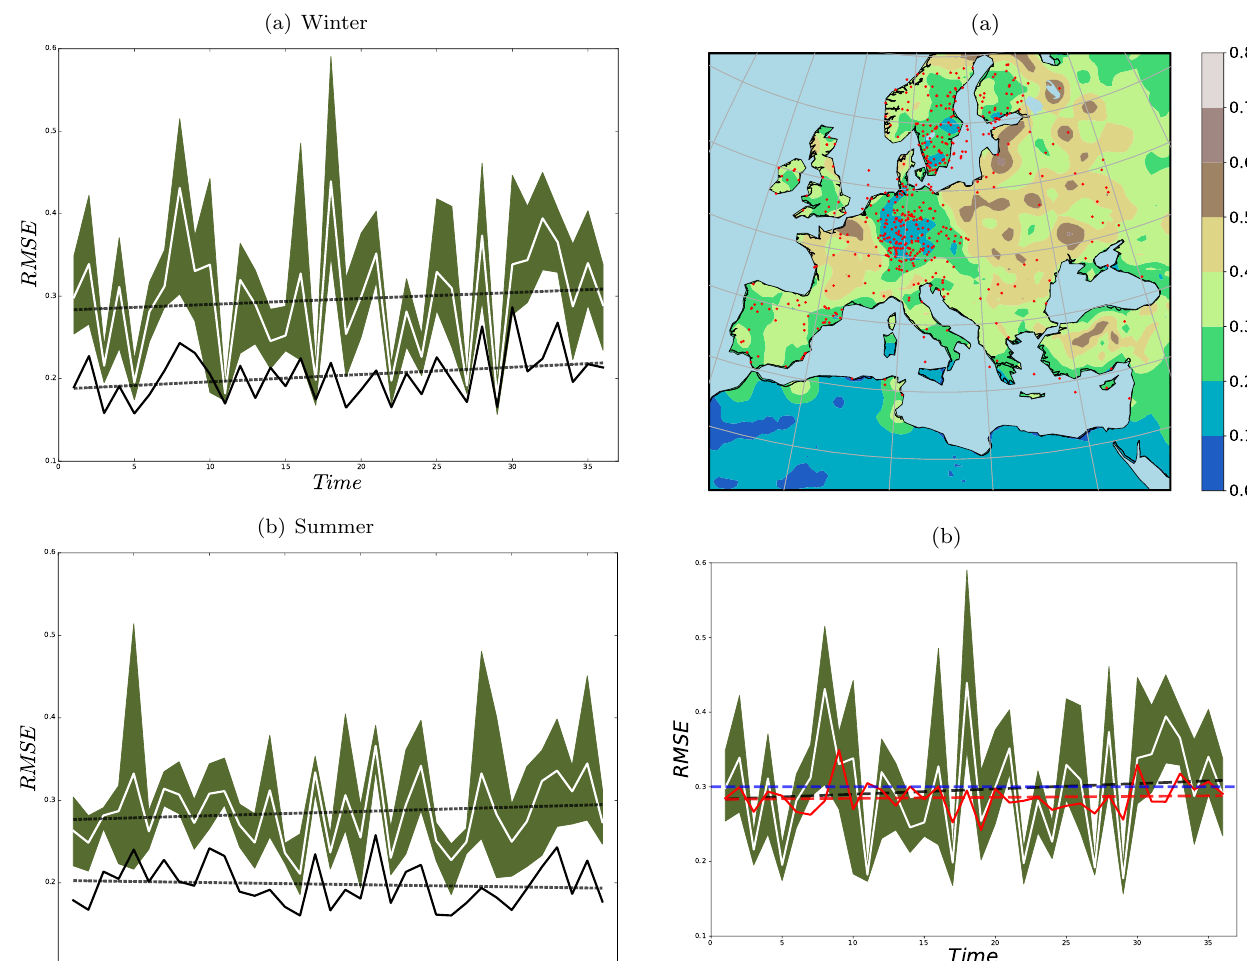
Figure 11. (a) 36-year-averaged RMSE of the analysis using 40 random states as background; (b) field mean of RMSE from the free ensemble (shading shows the ensemble spread, the white line the mean) and from the analysis using random background states (red line). Dashed lines are the linear fits and the blue line shows the 0.3K RMSE value (plotted only for comparison of the